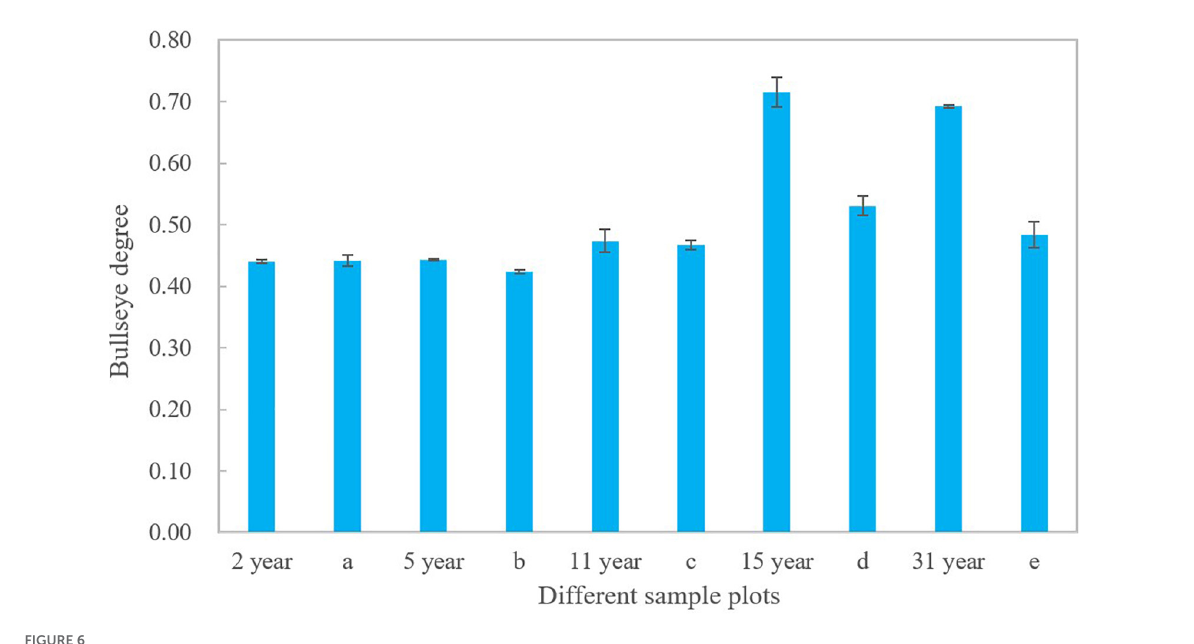
FIGURE6 Bullseye degree of soil quality in different sample